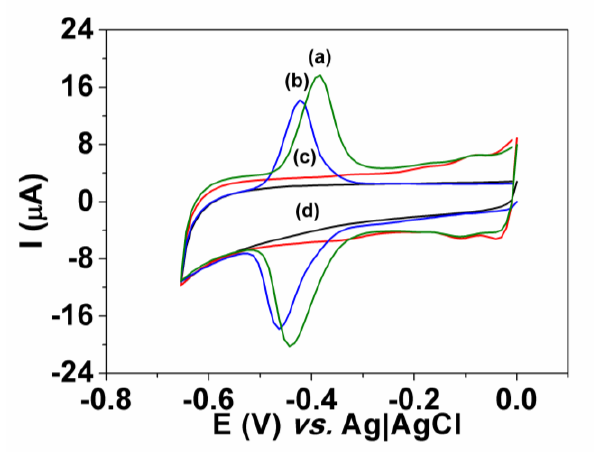
Figure 3. Cyclic voltammograms corresponding to the reduction of 1.0 × 10 −5 mol·L −1 AG25 in 0.04 mol·L −1 of B-R buffer, pH 4.0 on: ( a ) activated CNTME; ( b ) inactivated CNTME; ( c ) CNTME activated only in the supporting electrolyte; and ( d ) inactivated CNTME in the presence of the electrolyte. Scan rate: 60 mV·s −1 .